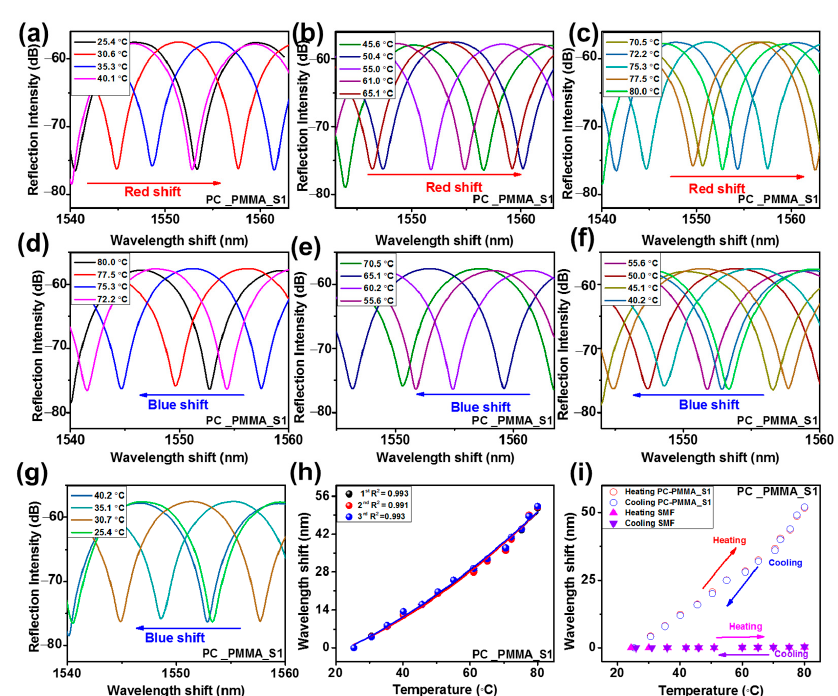
Figure 8. Reflected spectra with increases in temperature ( a – c ), decreases in temperature ( d – g ), wavelength shift for three measurements ( h ), and ( i ) average wavelength shift associated with SMF for PC_PMMA_S1 DPFPI.